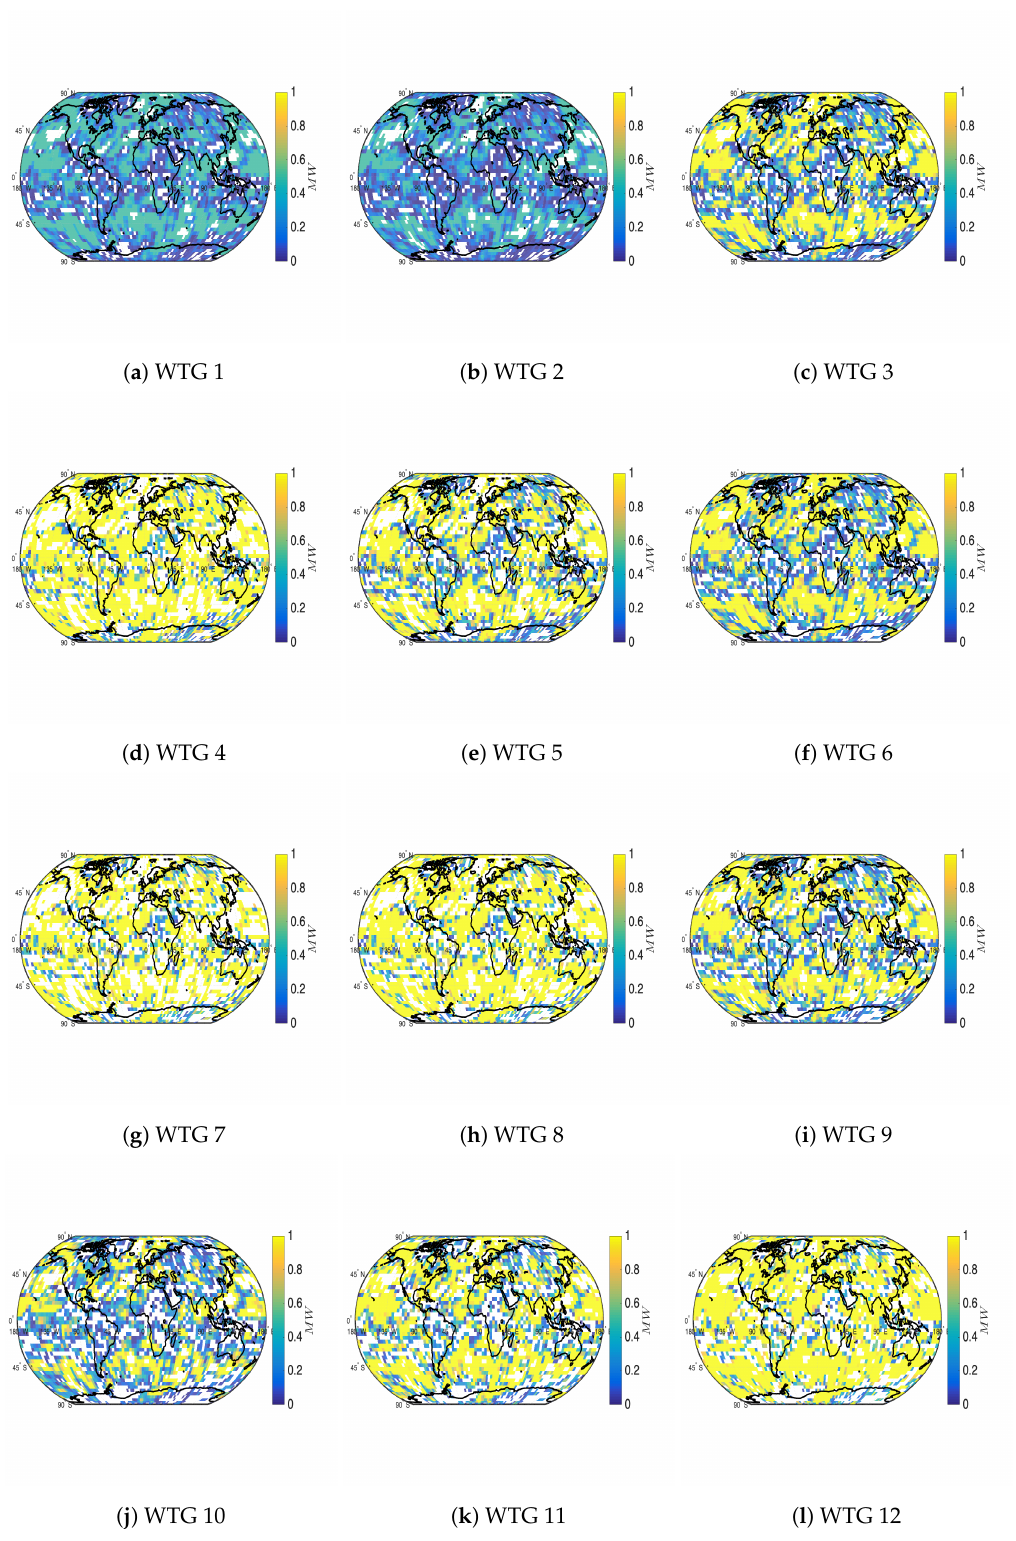
Figure 4. Mean of wind energy potentials for the 4D-Var-MC implementations. The number of ensemble members N = 20. White regions denote no wind-energy-potential generation. ( a ) WTG 1; ( b ) WTG 2; ( c ) WTG 3; ( d ) WTG 4; ( e ) WTG 5; ( f ) WTG 6; ( g ) WTG 7; ( h ) WTG 8; ( i ) WTG 9; ( j ) WTG 10; ( k ) WTG 11; ( l ) WTG